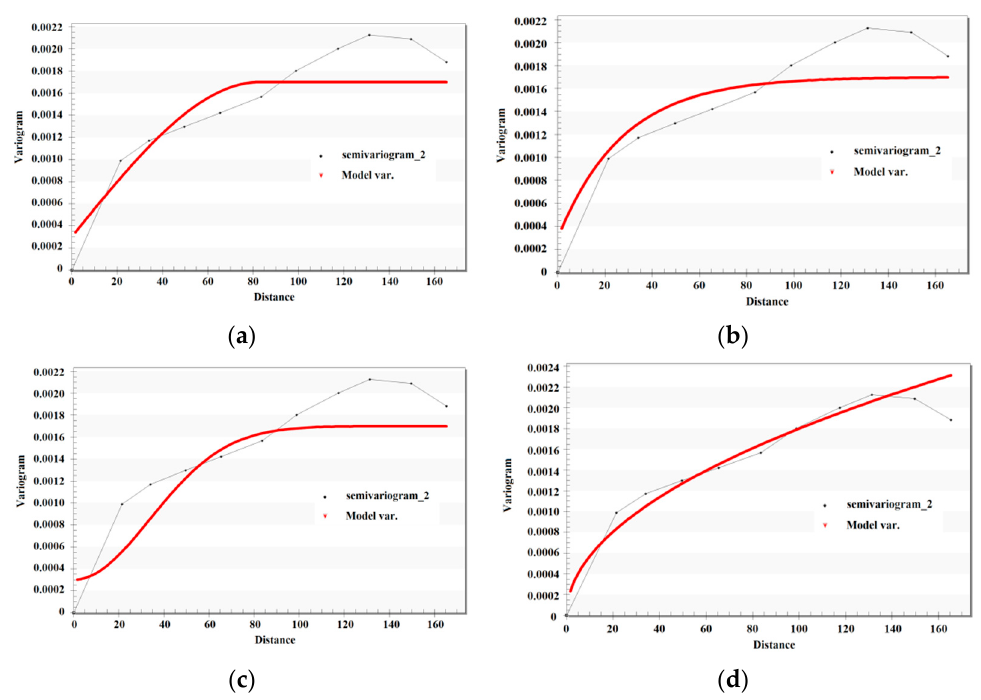
Figure 4. Experimental variogram and model variogram of uranium grade. ( a ) OK(spherical); ( b ) OK(exponential); ( c ) OK(gaussian); ( d )